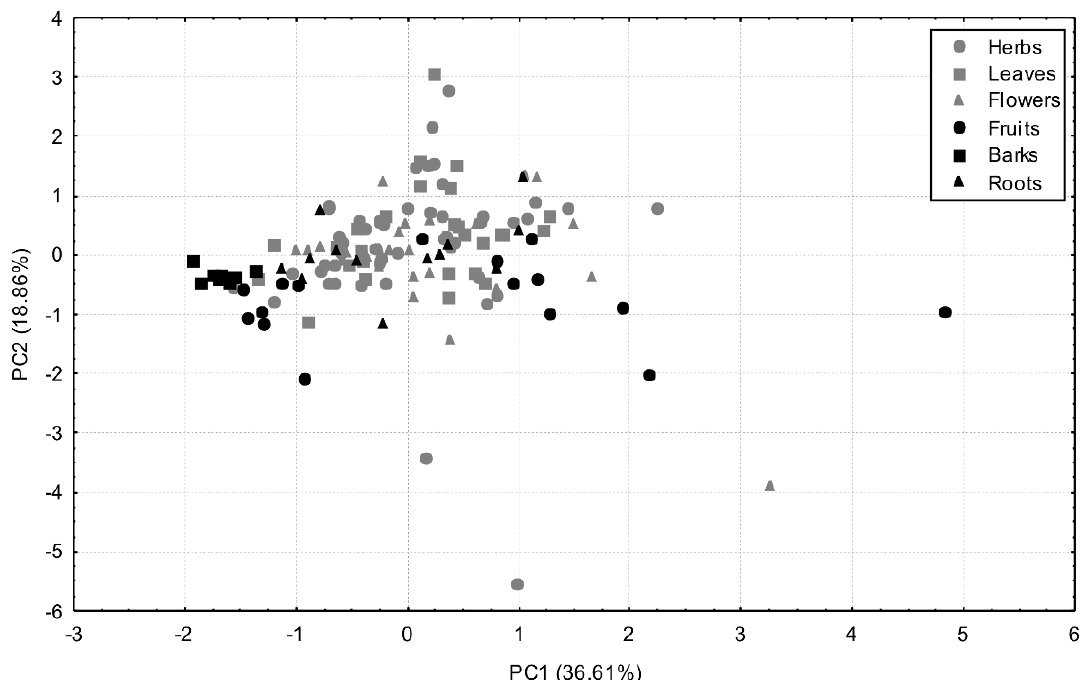
Figure 2. The first two principal component scores for herbal